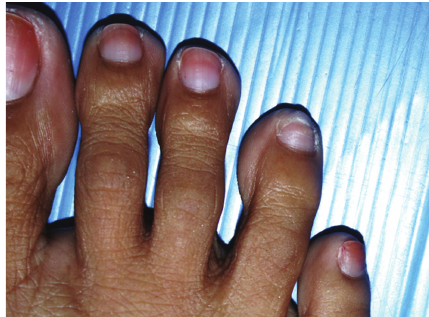
Figure 2: The affected toenail at the 4-month follow-up